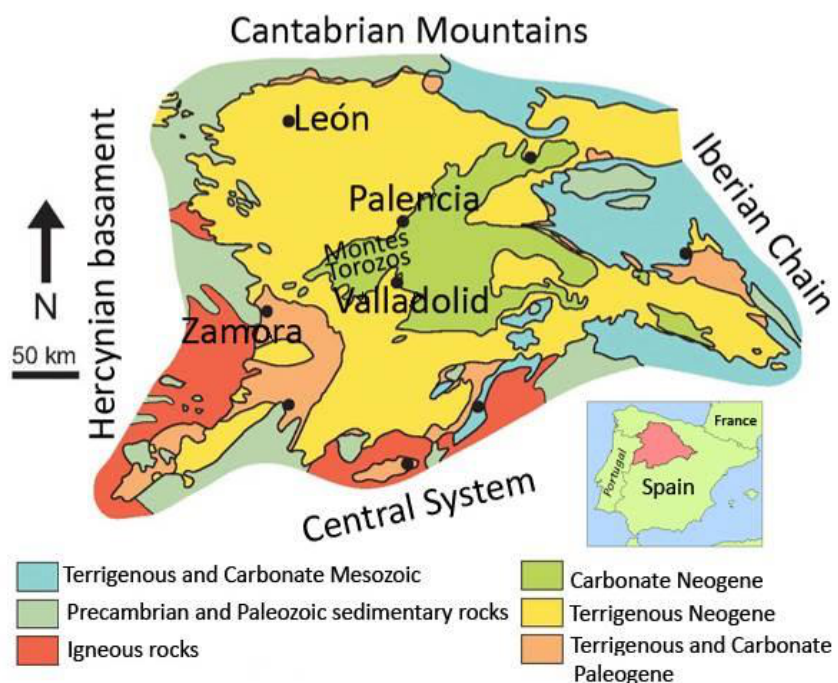
Figure 1. Geological context of the Duero Basin in the Iberian Peninsula (Modified from Armenteros et al. 2002).